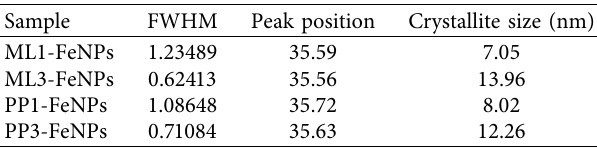
Figure 3: XRD pattern of Fe 3 O 4 NPs synthesized with molar ratios 2.8 :1 and 1.4 :1. (a) ML1-Fe 3 O 4 NPs. (b) ML3-Fe 3 O 4 NPs. (c) PP1- Fe 3 O 4 NPs. (d) PP3-Fe 3 O 4 NPs. Table 2: Magnetic nanoparticles prepared and their corresponding crystallite